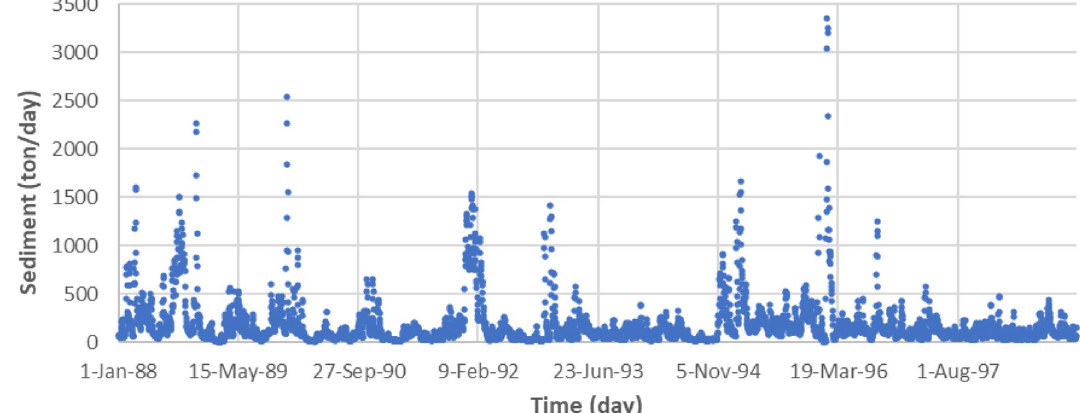
Figure 2. Sediment vs. time scatter plot for the Johor River basin from 1988 to 1998.